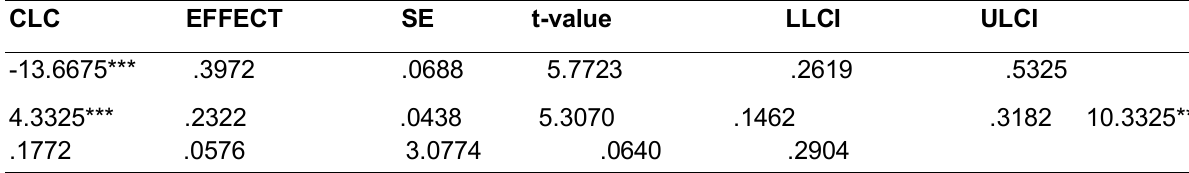
Table 9: Conditional effects of the focal predictor at values of the moderator CLC